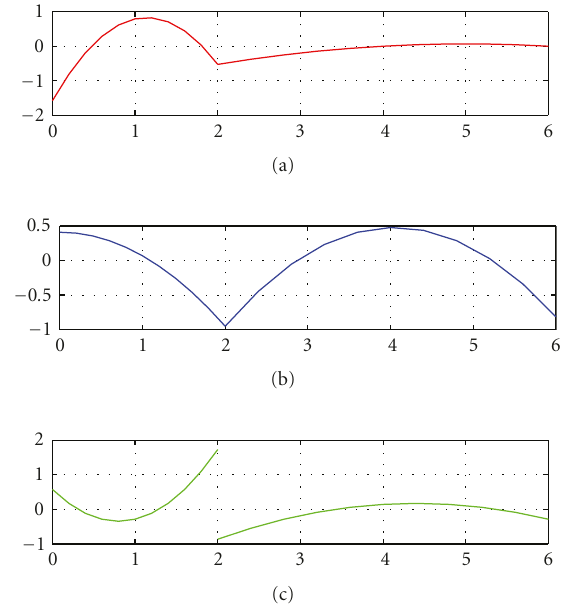
Figure 10: Orthonormal quadratic wavelet basis (two continuity